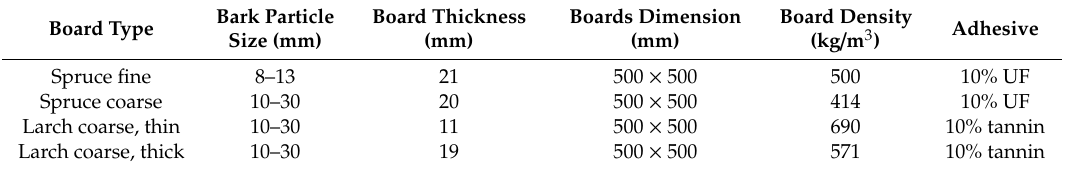
Table 1. Particle size, dimensions, density levels and adhesive type of the bark insulation boards.